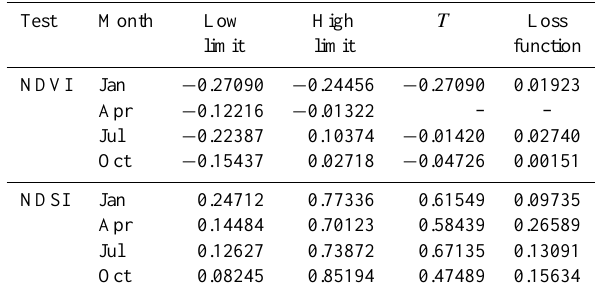
Table 3. Threshold values of NDVI and NDSI tests during four